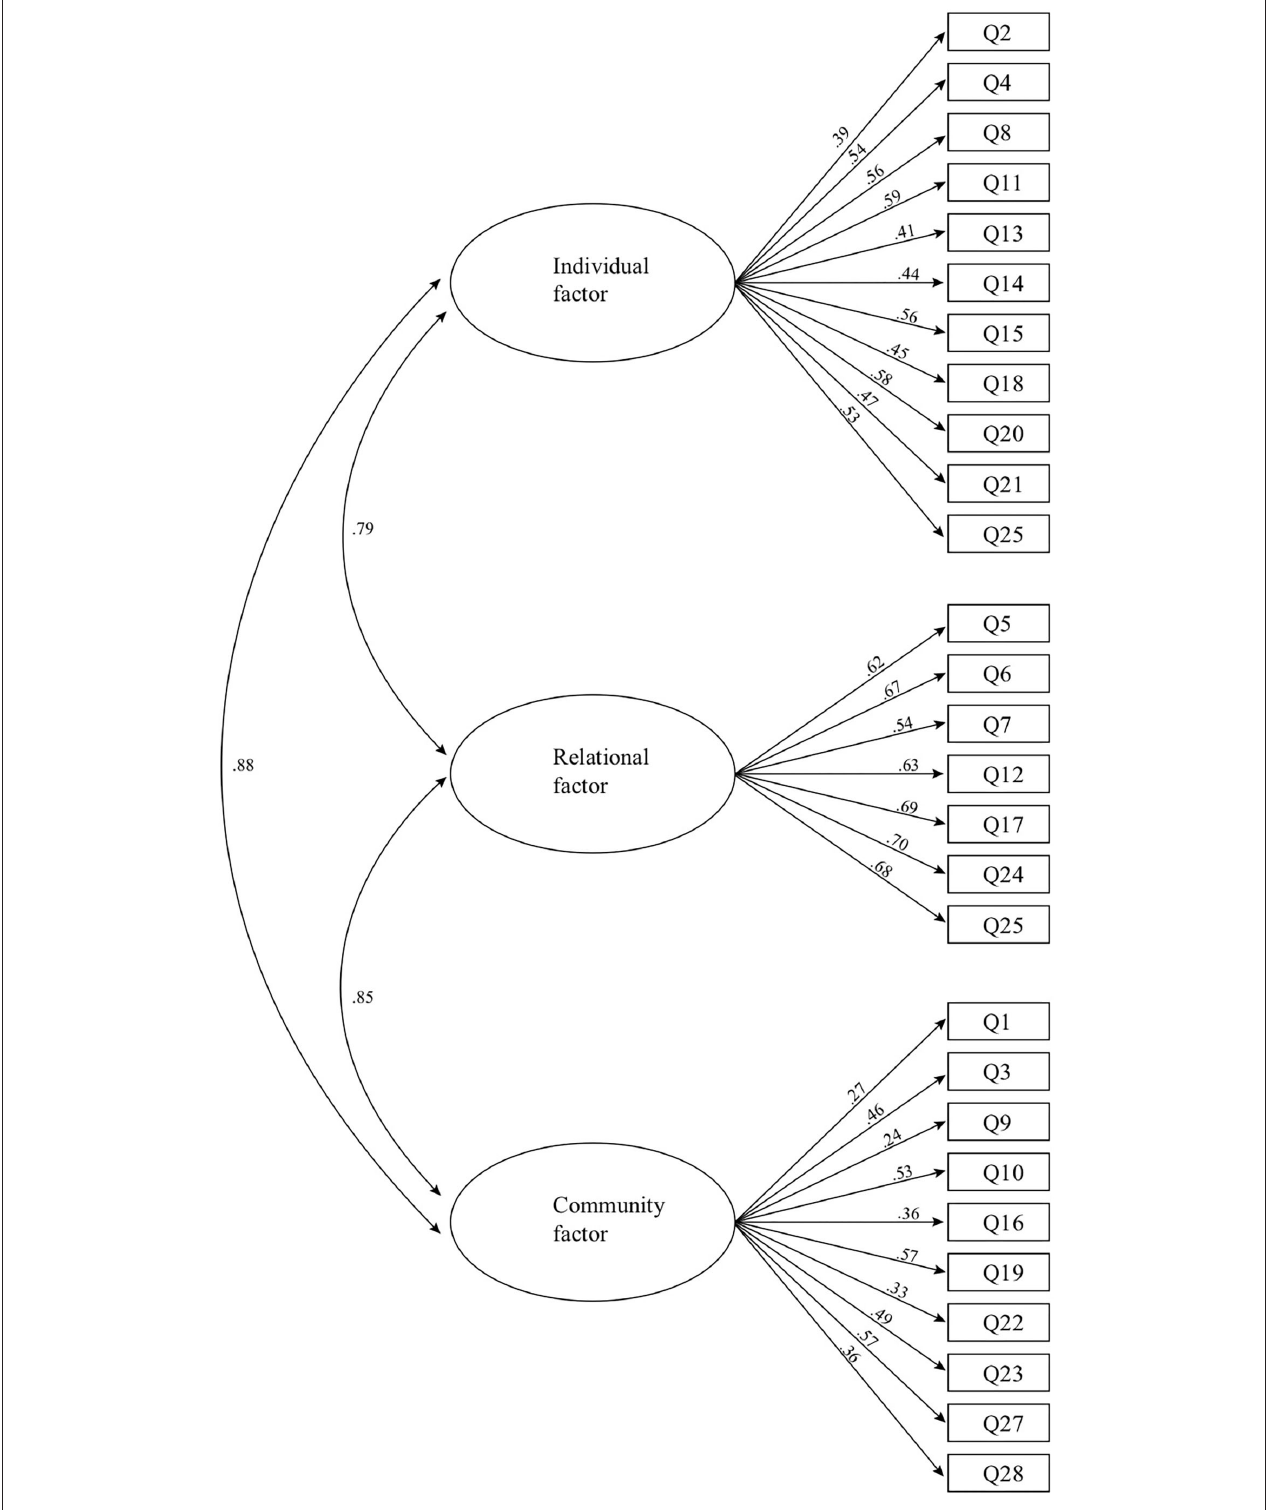
FIGURE 1 | Results of hypothesized